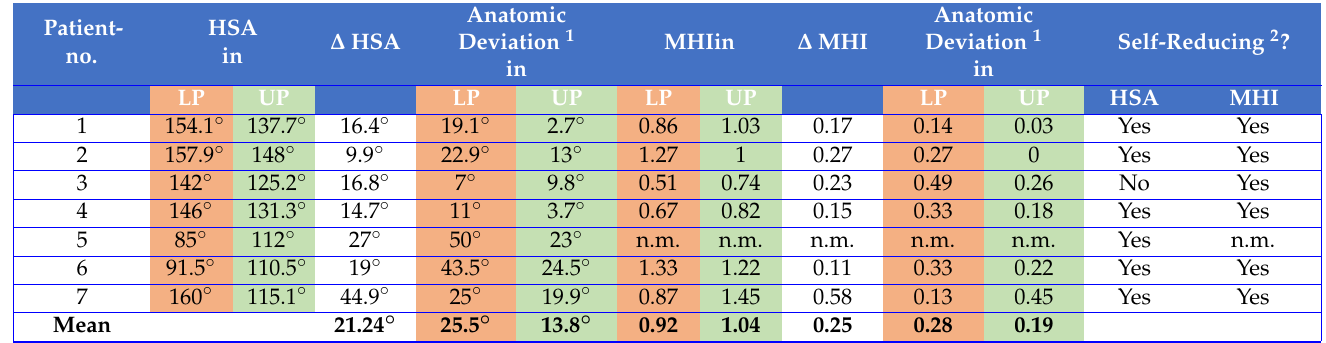
Table 2. Measured values of each patient using fluoroscopic assessments. LP = lying position (highlighted red); UP = upright sitting position (highlighted green); HSA = head-shaft angle; MHI = medial hinge index; ∆ HSA = difference of HSA between LP and UP; ∆ MHI = change of MHI between LP and UP; n . m . = not measured. 1 Anatomic deviation is defined as the residual amount of malalignment considering an HSA of 135 ◦ and MHI of 1 as ideal. 2 Self-reducing is defined as any change towards ideal